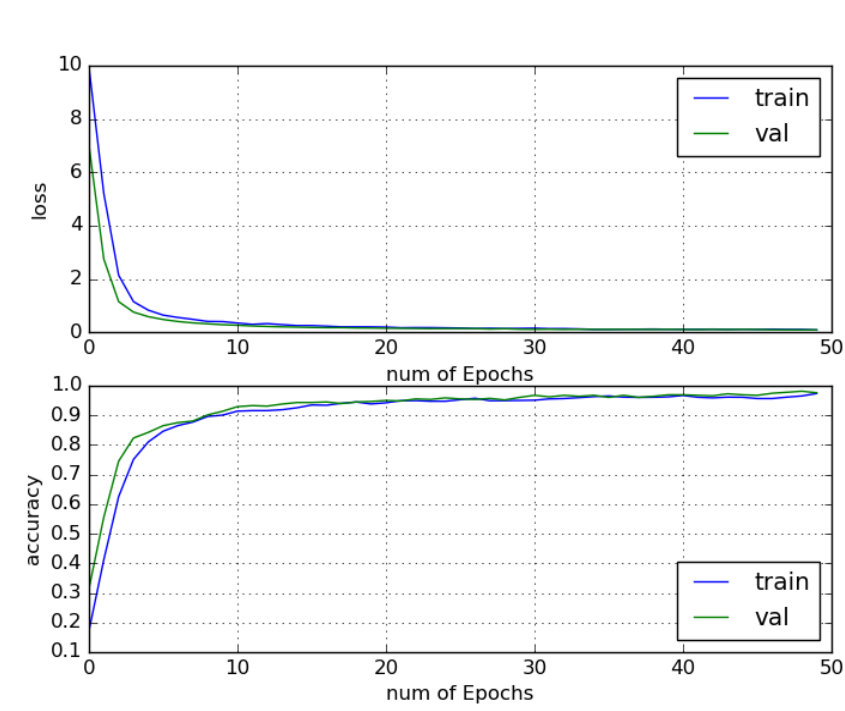
Figure 12. Fine tune DHCD model on Kaggle Devanagari numeral dataset using Adam optimizer.